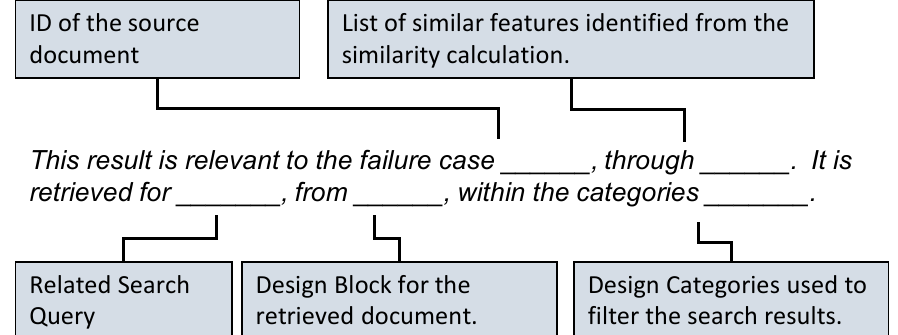
Figure 5. Verbal explanation template used in the implementation of Use Case 1. The template is designed based on expert requirements for explaining the semantic search results.